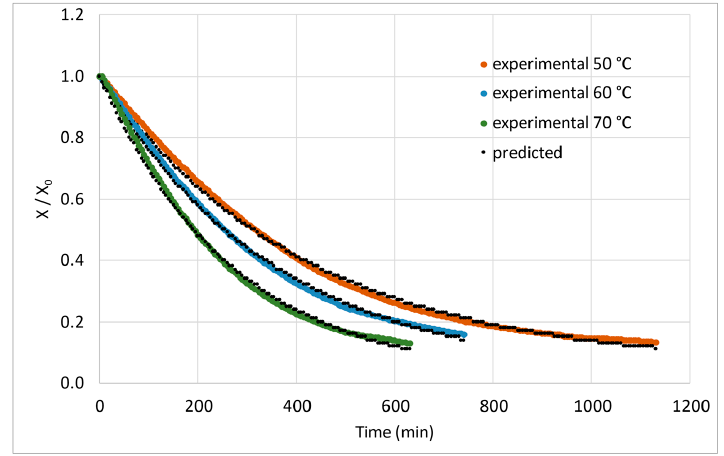
Figure 3. Normalised experimental data and values predicted by the Newton model for one replicate at each drying temperature. The following average values for the drying constants were obtained with the New- ton model: k 50 = 2.71 × 10 − 1 ± 3 × 10 − 3 min − 1 , k 60 = 2. 76 × 10 − 1 ± 4 × 10 − 3 min − 1 and k 70 = 3.91 × Table 6. Average values for L*, a* and b* obtained before processing, with standard deviation and coefficient of variance (CV).